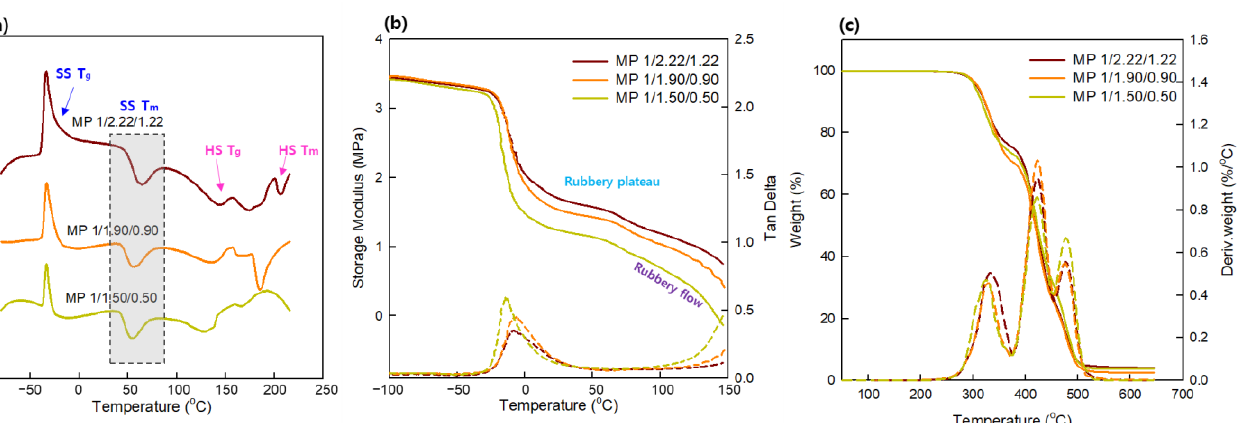
Figure 5. X-ray diffractograms of the bio-based SMTPUs.